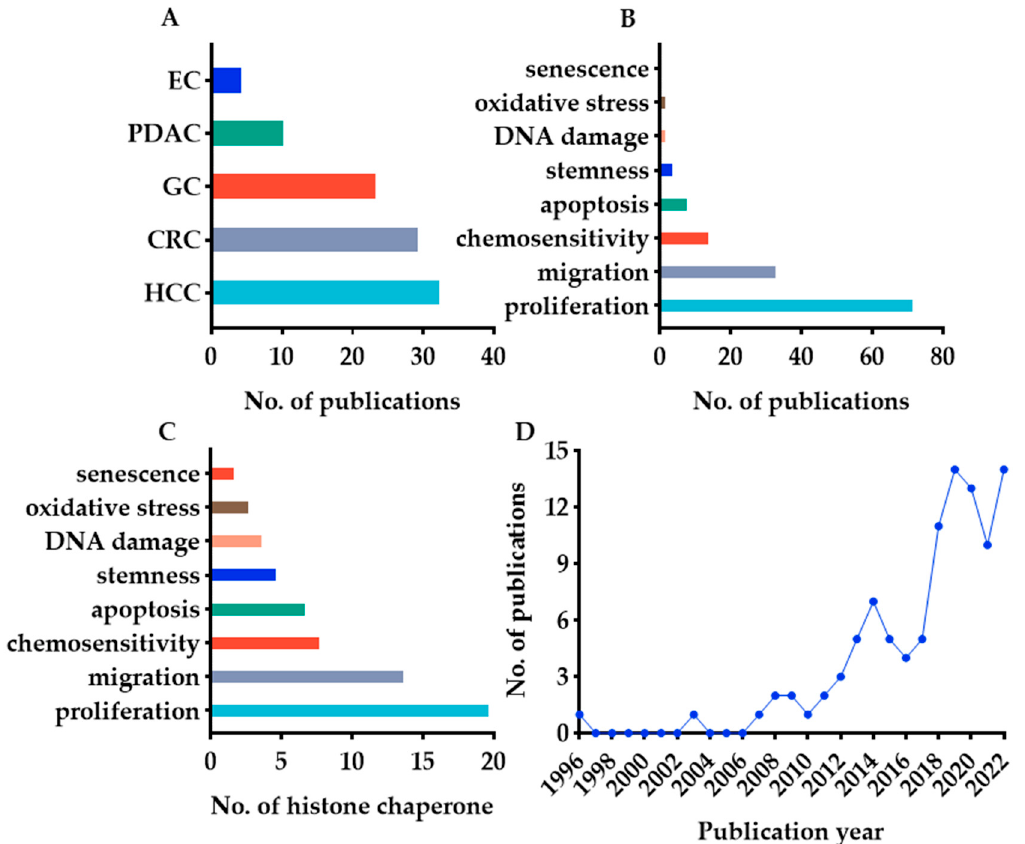
Figure 2. Search results of histone chaperones in digestive cancers. ( A ) Number of publications for selected histone chaperones in each digestive cancer; ( B ) number of publications for each phenotype of selected histone chaperones; ( C ) number of histone chaperones involved in each phenotype; ( D ) annual publications of histone chaperones in digestive cancers.